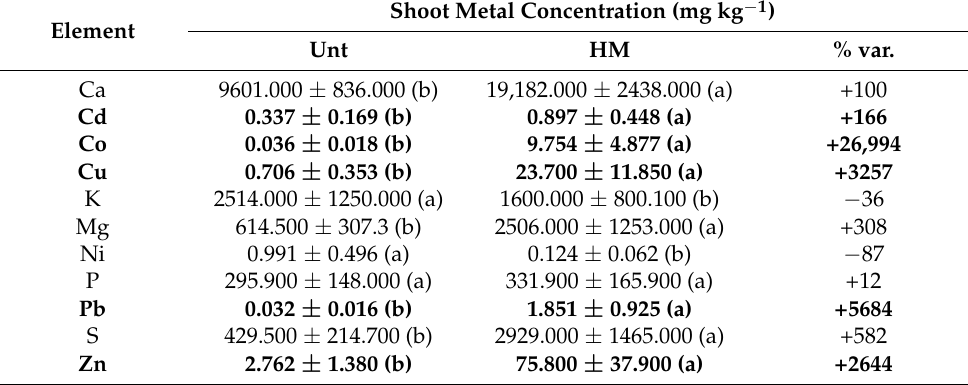
Table 3. Element concentrations (mg kg − 1 DW; ± SE; n = 4) in shoots of maize plants var. Naudi at the 3–4 leaf stage, after 41 days of cultivation in uncontaminated controls (Unt) vs. HM-contaminated soil, and % variation vs. Unt. Letters in brackets indicate significant differences between treatments in the same metal (Newman–Keuls test, p ≤ 0.05). Elements artificially added to the soil are highlighted in